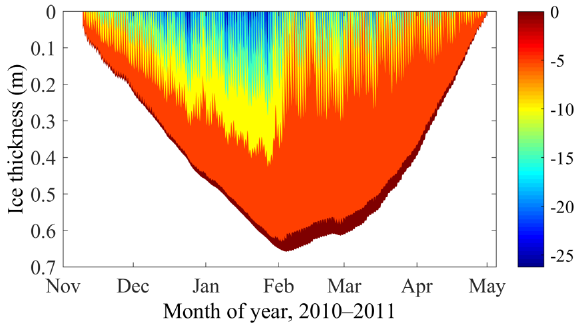
Figure 5. HIGHTSI modeled ice temperature regime for winter 2010–2011.